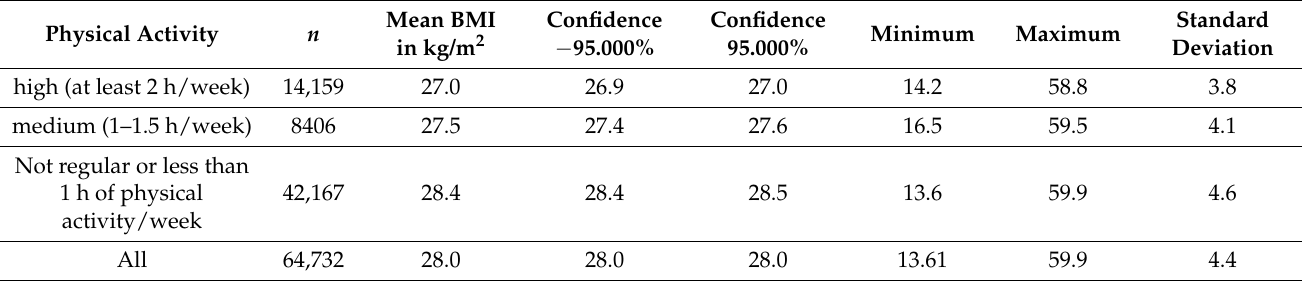
Table 4. Physical activity and BMI (all).